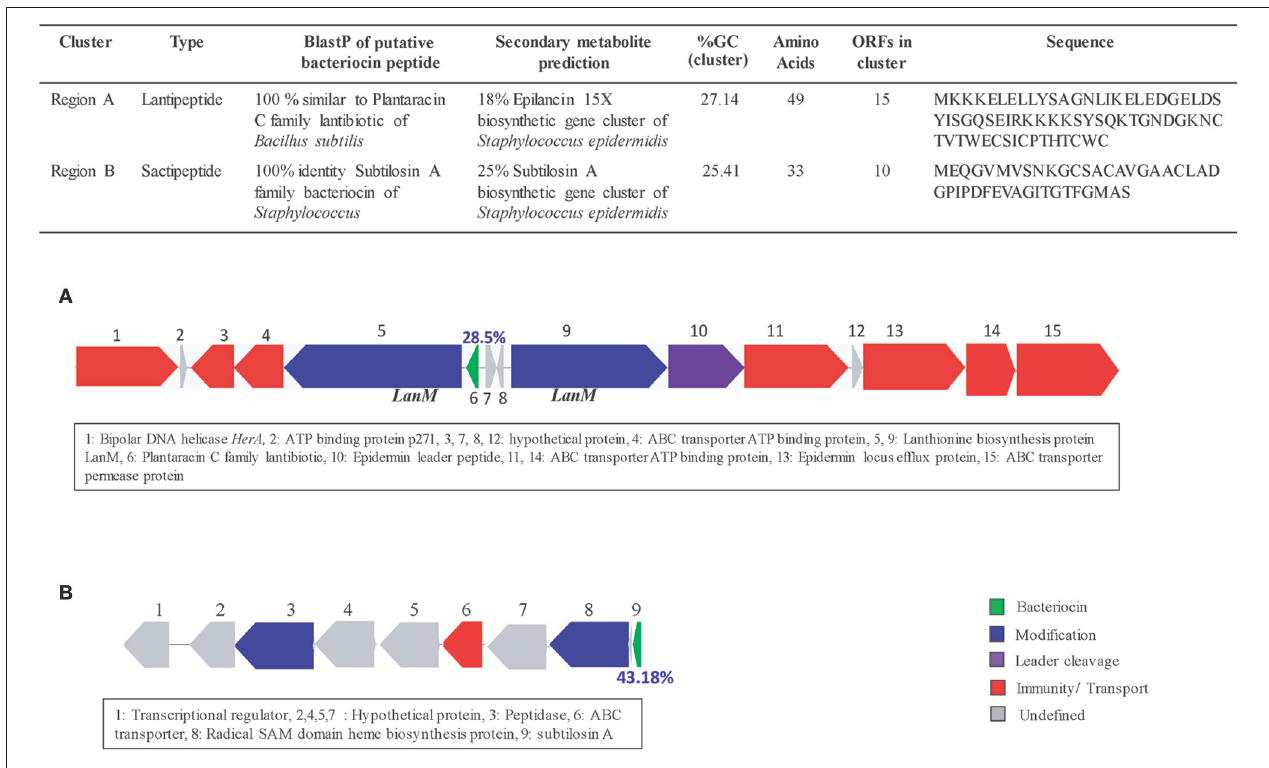
FIGURE 7 | Bacteriocin details of Indian isolates from PG1 lineage. (A) Putative bacteriocin cluster from a “plantaracin C family” lantibiotic and (B) Putative bacteriocin , “subtilosin A” sactipeptide biosynthetic gene cluster.